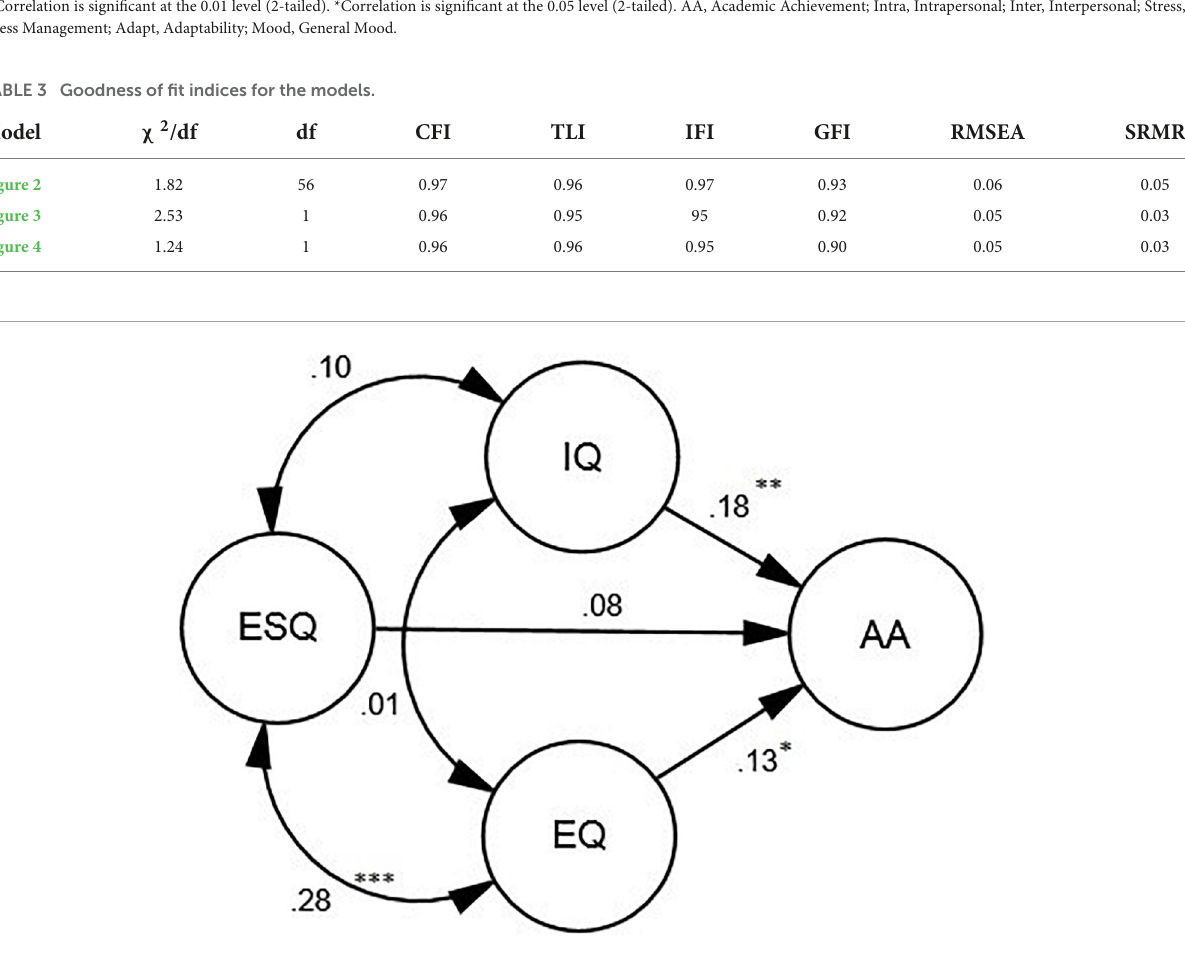
FIGURE2 The schematic representation of the relationships between the three types of intelligence (i.e., IQ, EQ, and ESQ) and Academic Achievement (AA). ∗ p < 0.05, ∗∗ p < 0.01, ∗∗∗ p <